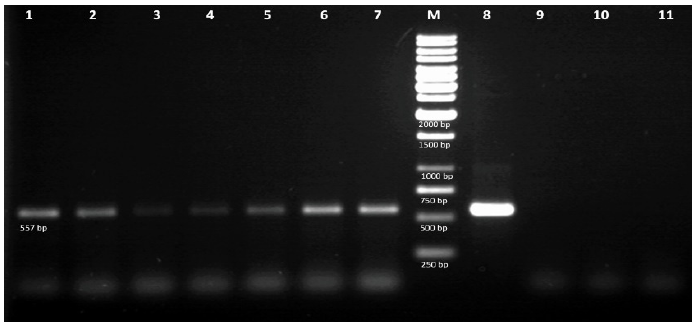
Figure 3. PCR analysis of transgenic hairy roots. 1-7—SOPSS 1-7 hairy root lines DNA, M—1 kb ladder, 8—pGFPGUSPlus-PgSS1 plasmid vector, 9—SOGFP hairy root line, 10—SOA4 hairy root